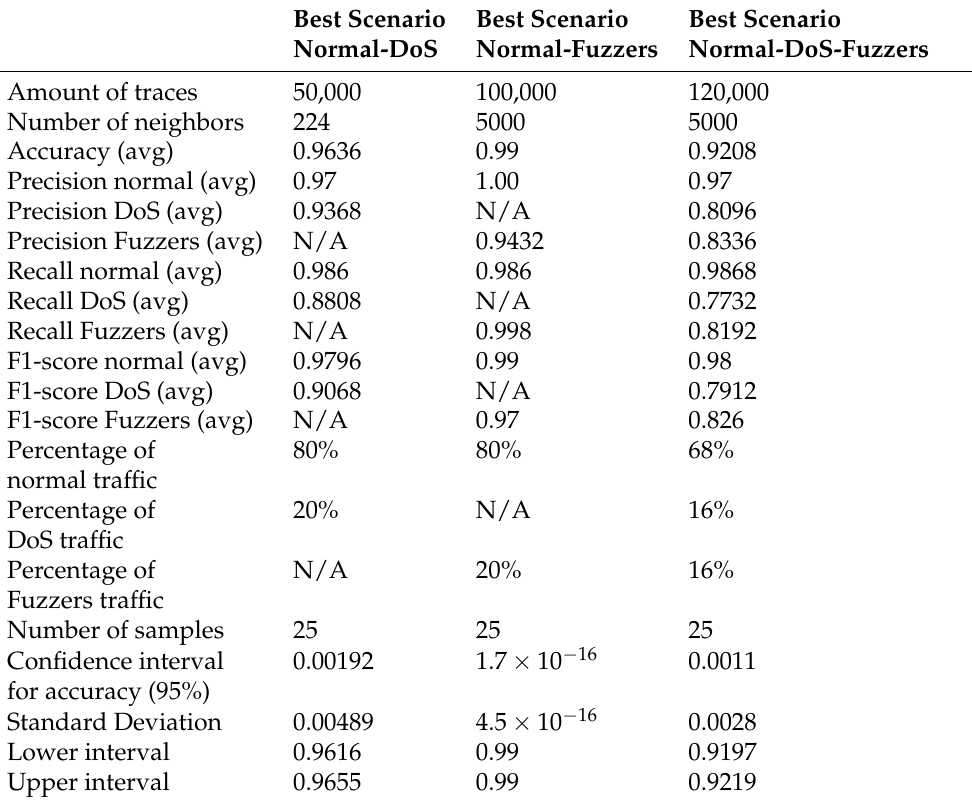
Table 5. Confidence interval